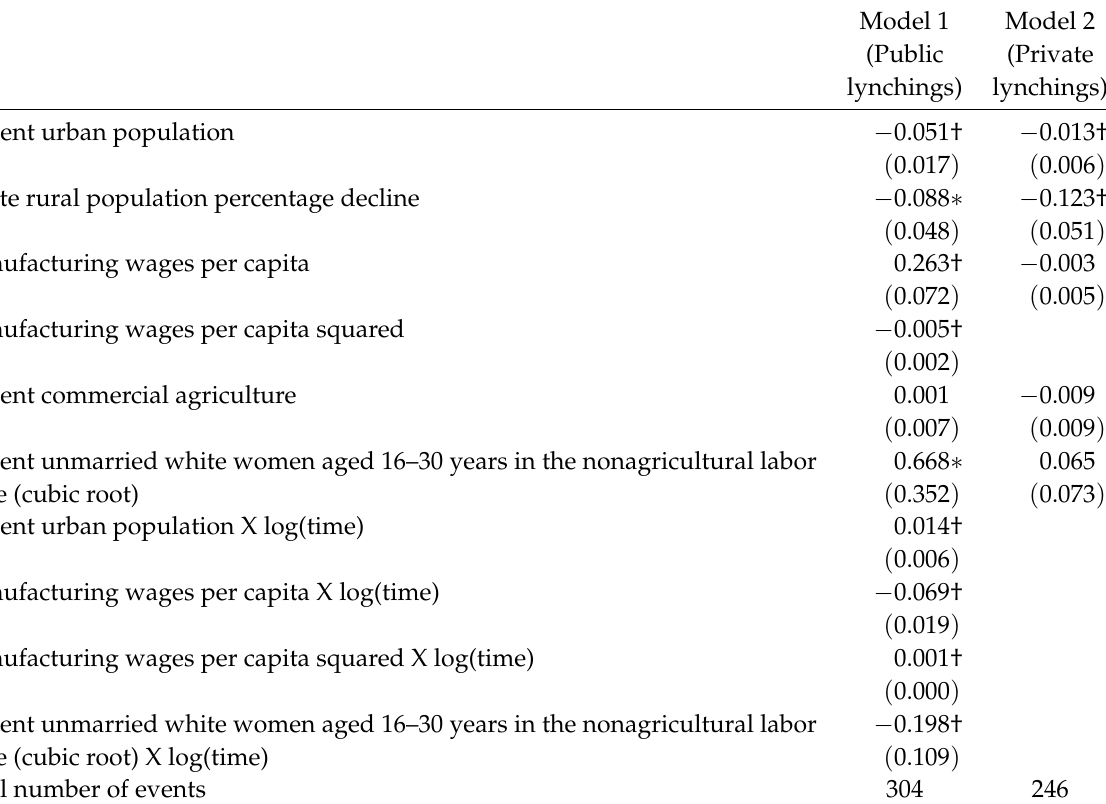
Table 1: Event history model estimations of the association between modernization and different lynching